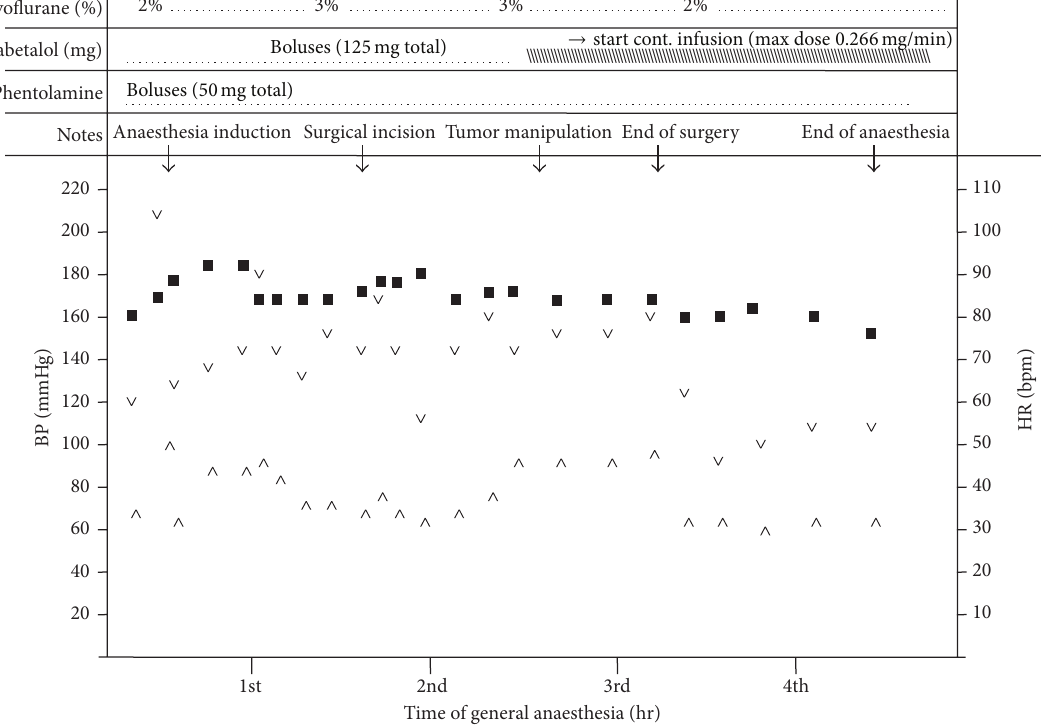
Figure 1: Anaesthesia management during surgery. ( ◼ ) heart rate; ( ∨ ) systolic blood pressure; ( ∧ ) diastolic blood pressure. As noted, during critical steps of surgery, it has been necessary to administer a greater amount of sevoflurane, in association with multiple boluses of beta-blocker. Total labetalol administered was 125 mg + continuous infusion 2 mg/mL with maximum administration of 0.266 mg/min. Phentolamine was administered by boluses of 1-2mg (50mg total).